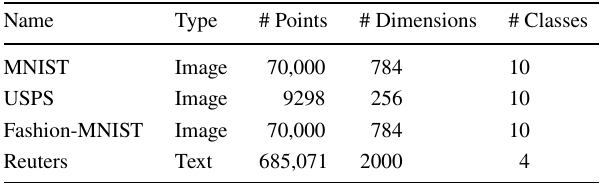
Table 1 Statistics of datasets used in the